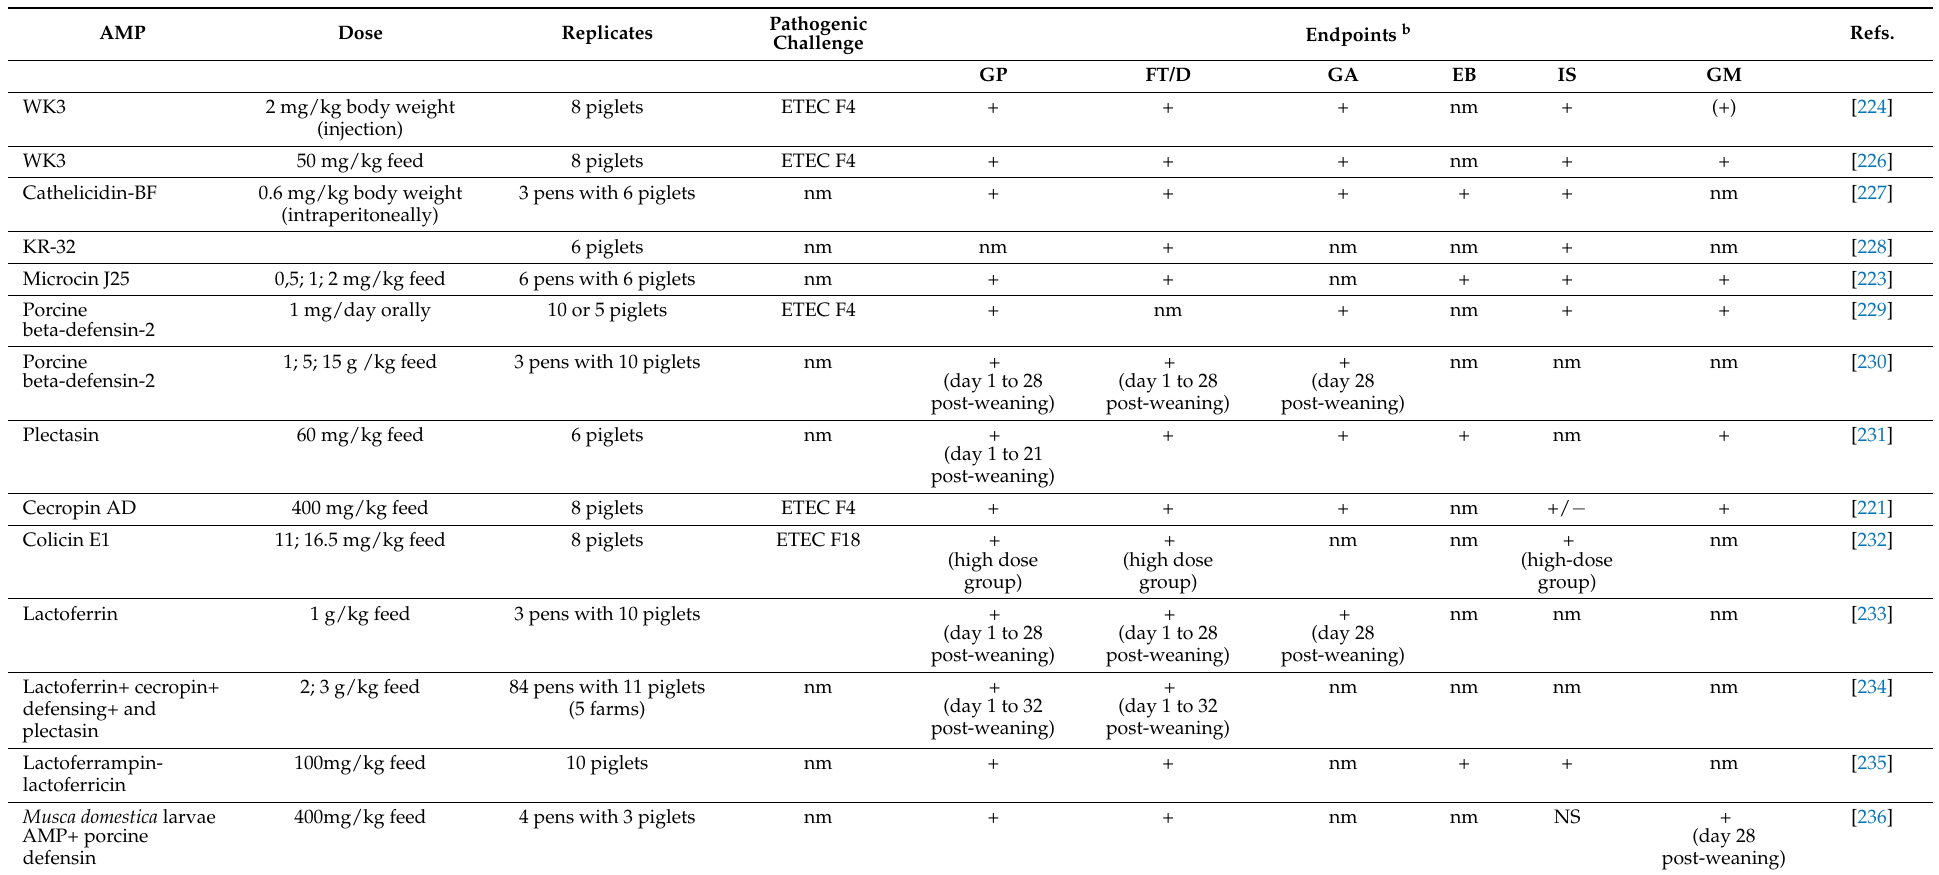
Table 8. Effects a of antimicrobial peptides (AMPs) on various parameters in